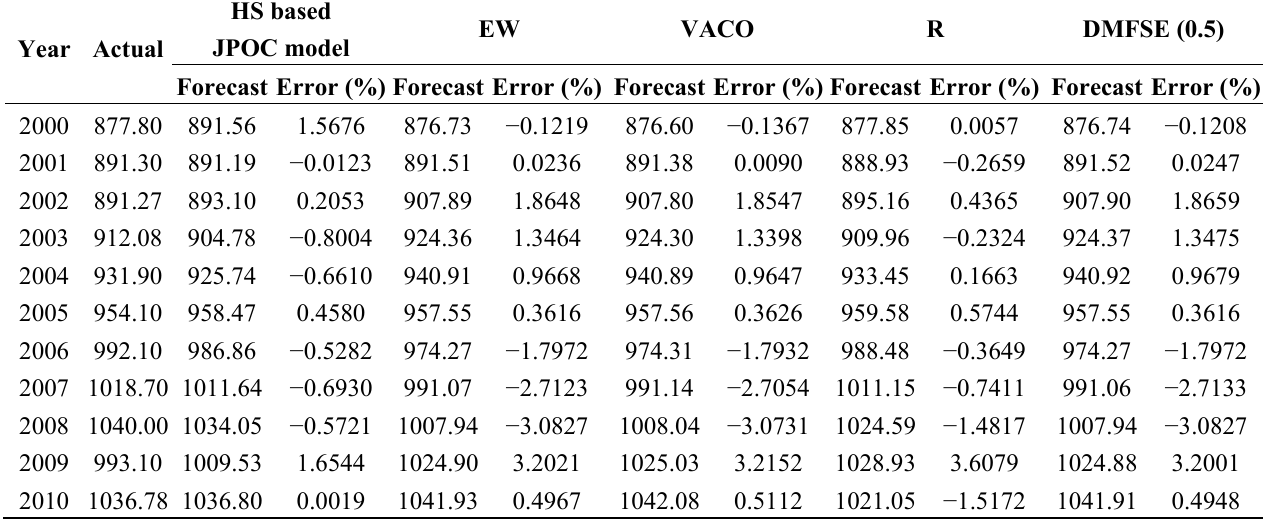
Table 10. Forecasting results of the HS-based JPOC model and the other combination models for the Russian Federation (TWh).